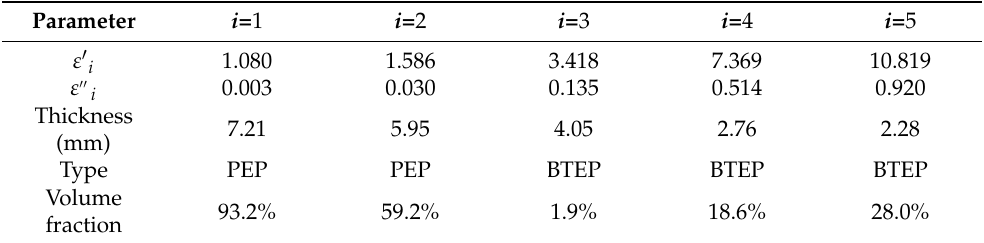
Table 3. Parameters of the 5-layer antireflection coating for matching free space and silicon as schematically illustrated in Figure 6a. i denotes the layer number. PEP (BTEP) represents the porous epoxy (BaTiO 3 –epoxy)